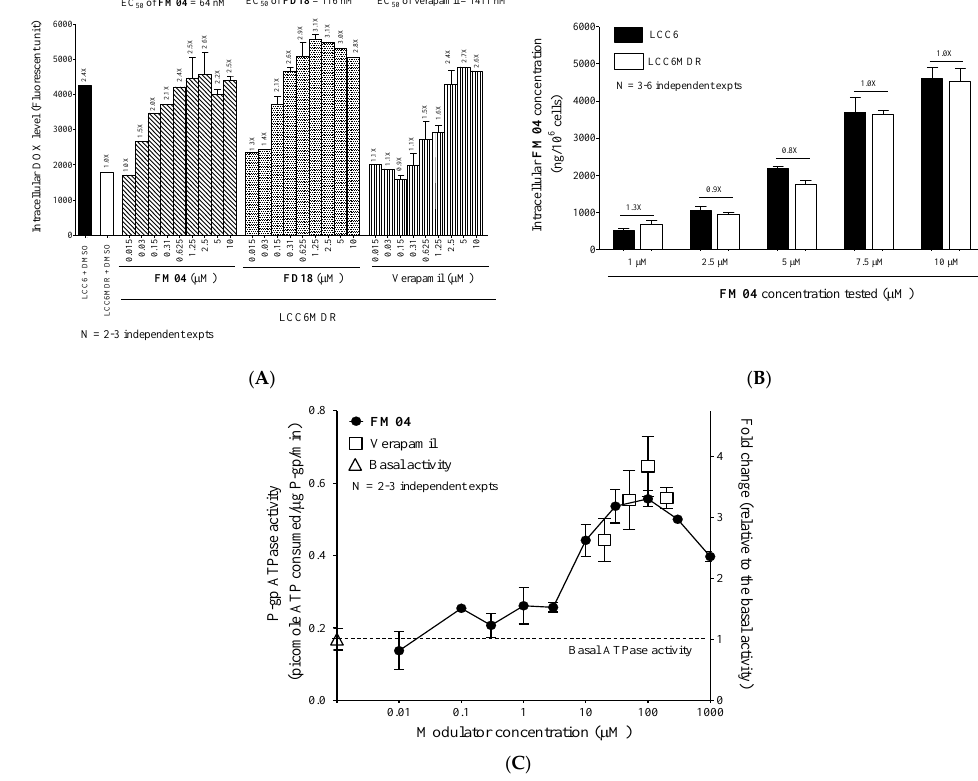
Figure 4. Mechanistic study of FM04 to reverse P-gp-mediated drug resistance. ( A ) LCC6MDR cells were co-incubated with 20 μ M DOX and various concentrations of modulators (0.015, 0.03, 0.15, 0.31, 0.625, 1.25, 2.5, 5 and 10 μ M) including FM04 , FD18 and verapamil at 37 °C for 150 min. After incubation, the cells were lysed and the intracellular DOX level was determined by fluorescence microplate reader. EC 50 (nM) was an effective concentration of modulator at which it can increase the DOX retention by 50%. The fold change of DOX concentration after each modulator treatment was relative to that of LCC6MDR treated with DMSO. The DOX levels were presented as mean ± standard error of mean. N = 2 – 3 independent experiments. ( B ) LCC6MDR and LCC6 cells were incubated with different concentrations of FM04 (1, 2.5, 5, 7.5 and 10 μ M) at 37 °C for 120 min. After incubation, the cells were lysed and spun down. The concentration of FM04 in the supernatant was measured by UPLC-MS/MS. The values were presented as mean ± standard error of mean. N = 2 – 6 independent experiments. ( C ) membrane vesicles containing recombinant human P-gp were incu- bated with a series concentrations of FM04 (0.01, 0.1, 0.3, 1, 3, 10, 70, 100, 300 and 1000 μ M) and verapamil (20, 50, 100 and 200 µM) at 37 °C for 120 min. A 1% DMSO was a solvent control. After incubation, the level of the remaining ATP within the reaction system was measured through lumi- nescence changes. The ATPase activity after each treatment was relative to the basal activity and presented as fold change. The values were presented as mean ± standard error of mean. N = 2 – 3 independent experiments.